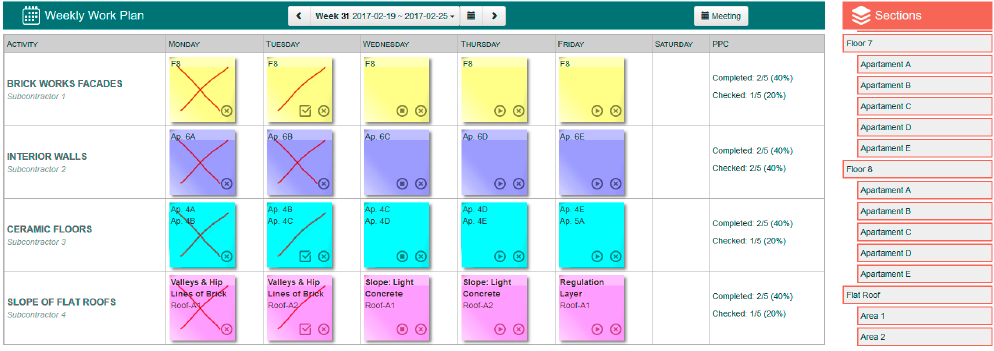
Figure 17. Screenshot from the LPS WebApp of the weekly work plan at week 31.